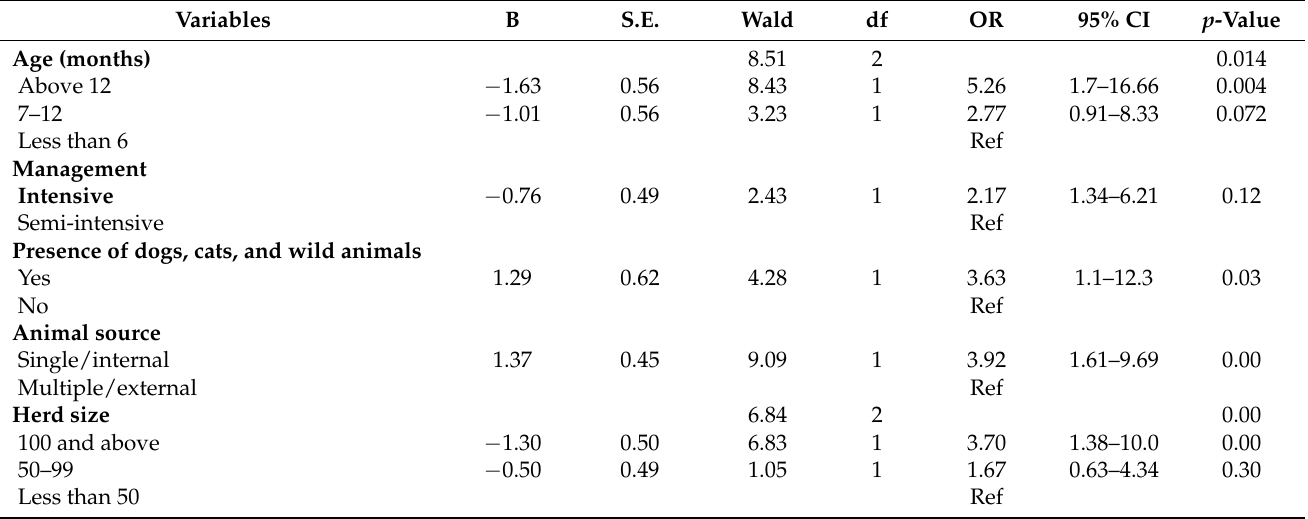
Table 4. Final mixed-effects logistic regression model of the factors associated with the prevalence of T. gondii antibodies in goats from 13 farms in Selangor, Malaysia.